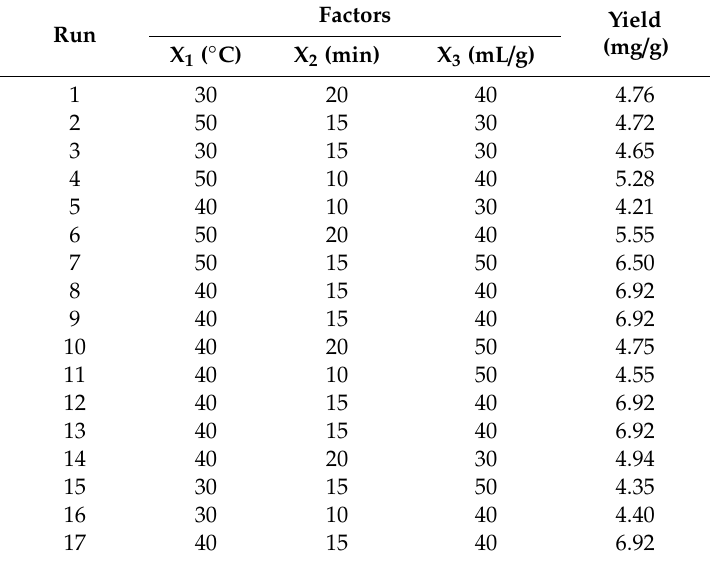
Table 1. The experimental results of the Box-Behnken Design: X 1 , X 2 and X 3 are temperature, time, and liquid-to-solid ratio, respectively.